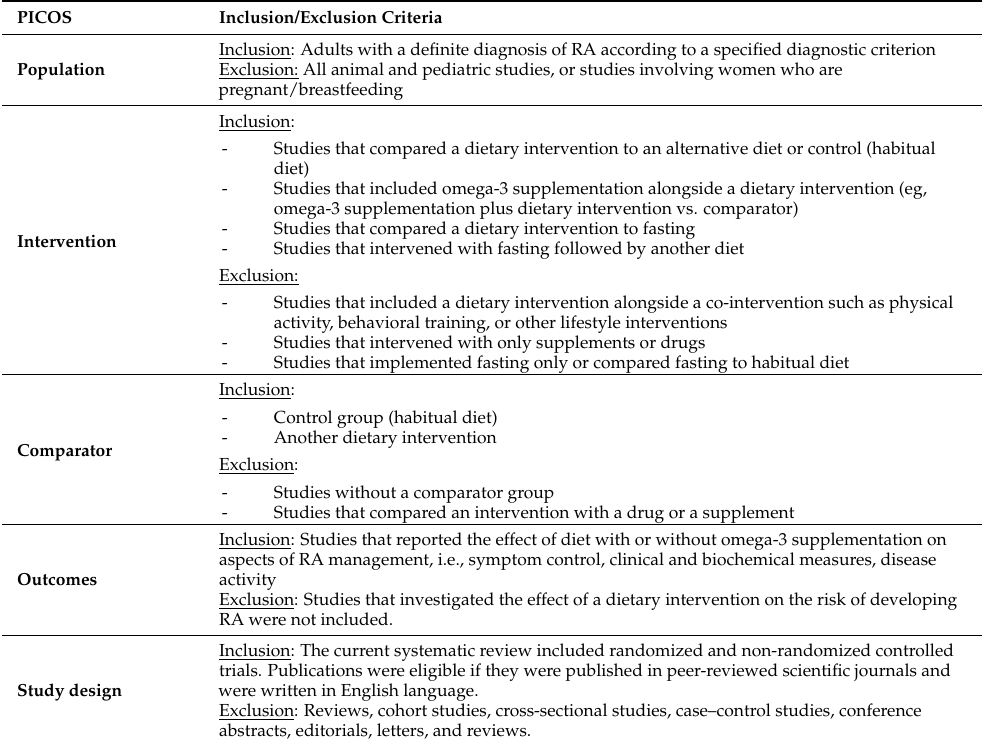
Table 1. PICOS criteria for inclusion and exclusion of